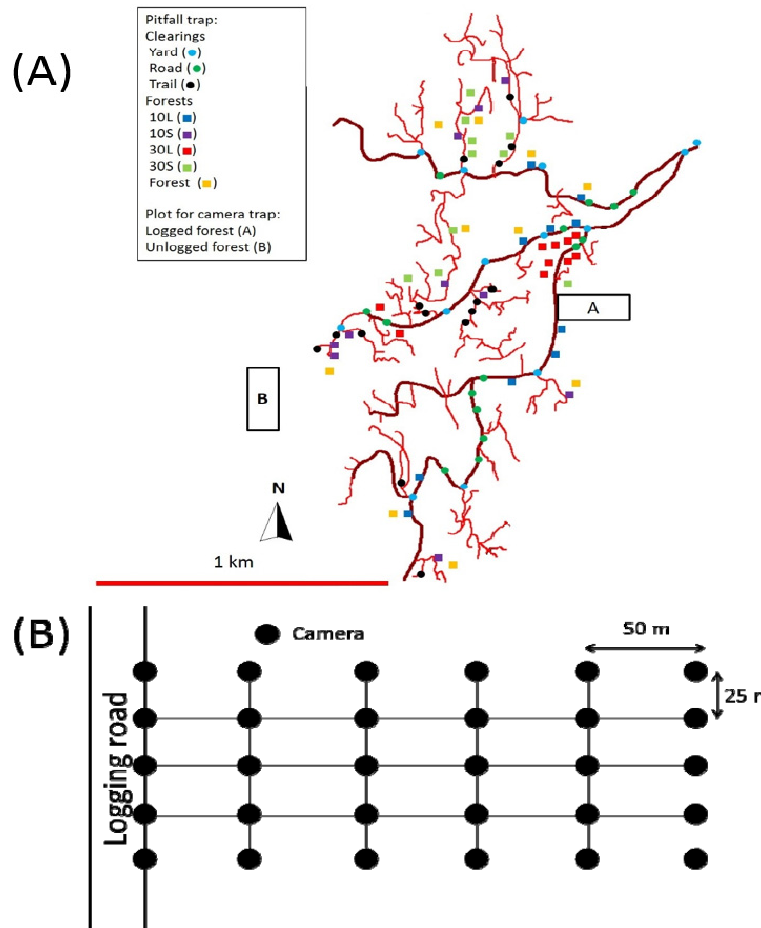
Figure 2. ( A ) Locations of pitfall traps at block five of the Temengor Forest Reserve. Thick and thin red lines indicate logging roads and skid trails, respectively. In the figure, “Yard,” “Road, and Trail” indicate pitfall traps at log-yards, logging roads, and at skid trails, respectively. 10 L, 30 L, 10 S, 30 S and Forest represent forests at 10 m or 30 m from logging roads, forests at 10 m or 30 m from skid trails and forests at 60 m from logging roads, respectively. The locations of plots for camera traps are also shown; A, plot in a logged forest; B, plot in an unlogged forest; ( B ) Camera grid system pattern set in forests in the Temengor Forest